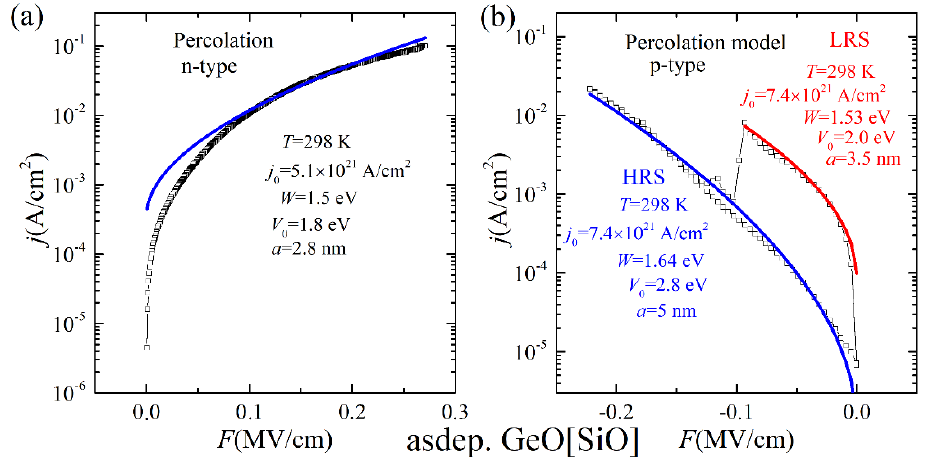
Figure 8. Experimental I–V characteristics of the high resistance state (HRS) and low resistance state (LRS) in as-deposited GeO[SiO] films and simulations (colored lines) with the Shklovskii–Efros (S–E) percolation model ( a ) on the n + -type Si substrate and ( b ) on the p + -type Si substrate.